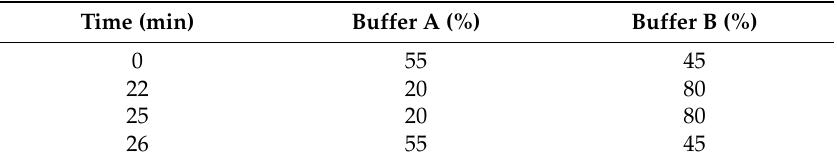
Table 5. Gradient parameters for HPLC analysis of crude oligonucleotide. Data acquisition time is 30 min with a 10 min post time for column equilibration. Buffer A is 5 mM tributylammonium, 1 µ M EDTA in 10% acetonitrile. Buffer B is 5 mM tributylammonium acetate, 1 µ m EDTA in 80% acetonitrile. Flow rate is 0.25